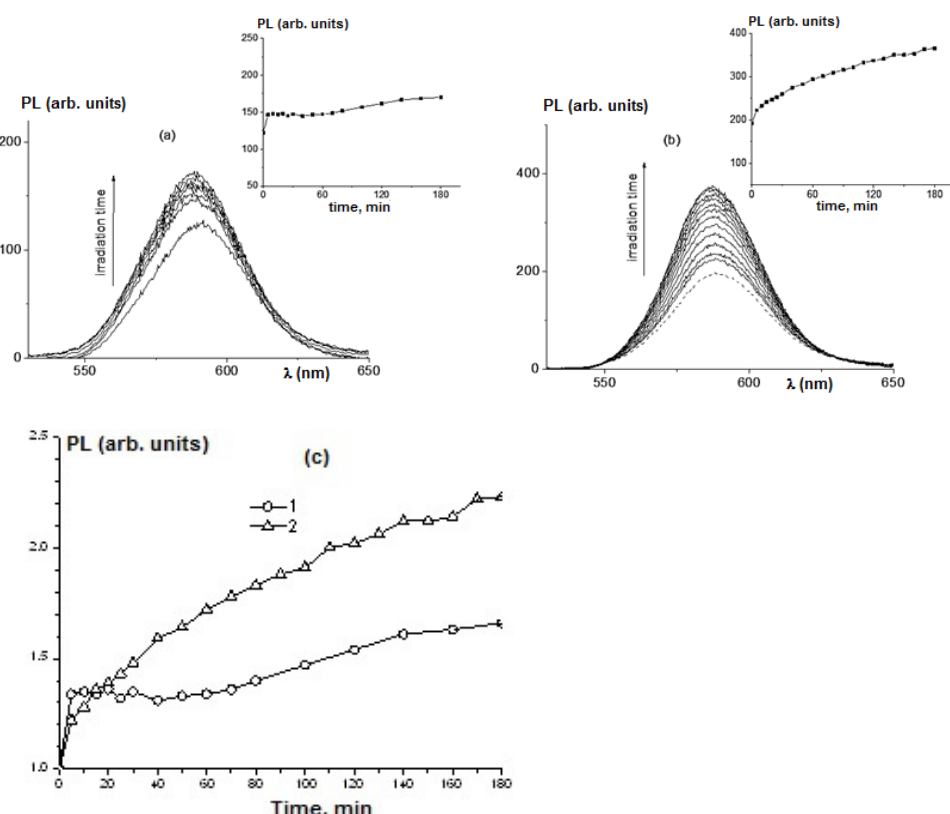
Figure 10. Photoluminescence spectra of sols of CdSe QDs stabilized by oleic acid ( a ) and M1 ( b ) in toluene under continuous irradiation ( λ ex = 520 nm) for various times (from 0 to 180 min). The insets: Time dependence of the intensity of photoluminescence at λ = 576 nm for sols of CdSe QDs stabilized by oleic acid (1) and M1 (2) in toluene under continuous irradiation; ( c ) normalized PL intensities for sols of CdSe QDs stabilized by oleic acid (1) and M1 (2).